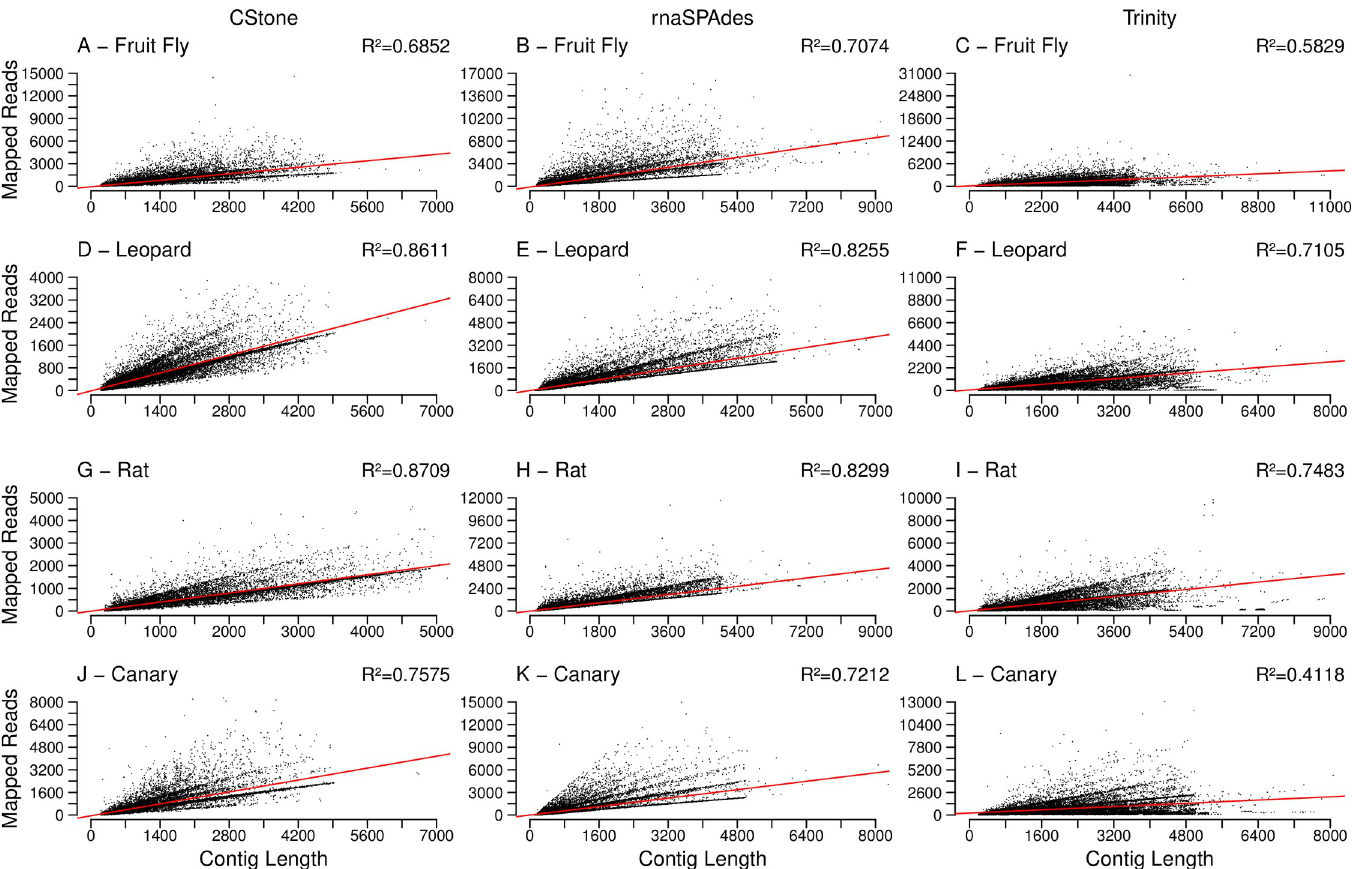
Fig 5. Lengths of contigs versus the number of reads mapping to them. The assembler used is indicated along the top of the figure, while the x-axis is labeled along the bottom. The red line indicates the line of best fit based on a linear model. R 2 values, located on the top right corners, indicate the correlation between mapped read counts and contig lengths, p-values of which are discussed in the